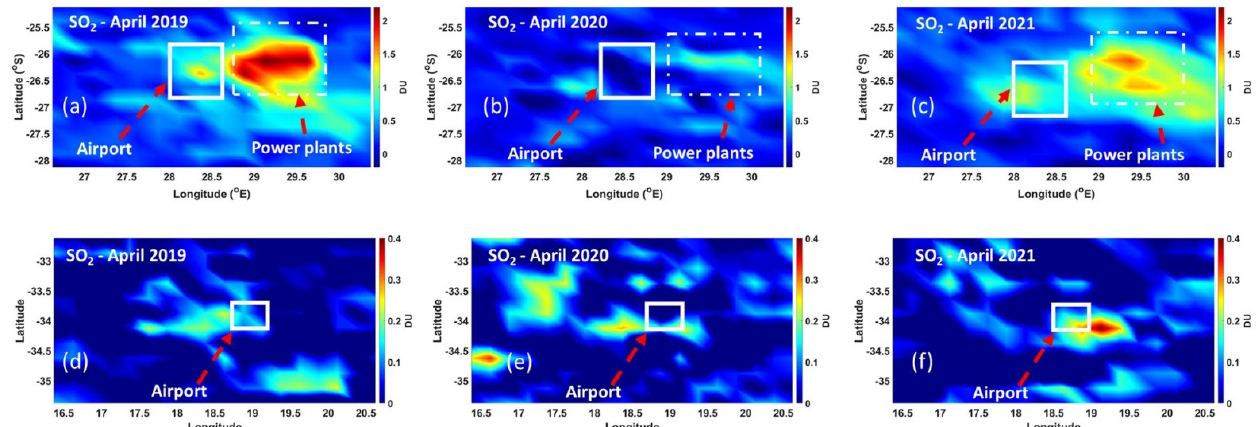
Figure 6. SO 2 tropospheric column and distribution for the month of April ( a ) before the Level-5 lockdown over OR Tambo International Airport (FAOR), ( b ) during the lockdown Level-5 over FAOR, and ( c ) after the Level-5 lockdown over FAOR; ( d ) before the Level-5 lockdown over Cape Town International Airport (FACT), ( e ) during the lockdown Level-5 over FACT, and ( f ) after the Level-5 lockdown over FACT.